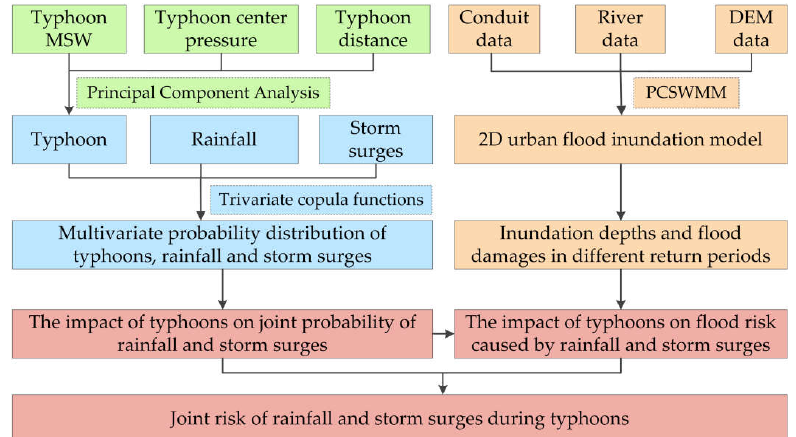
Figure 4. The overall framework. MSW: maximum sustained wind; DEM: digital elevation model; PCSWMM: Personal Computer Storm Water Management Model.